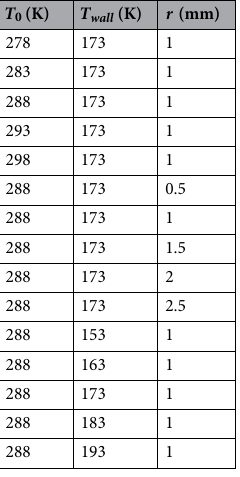
Table 5. Single factor simulation data